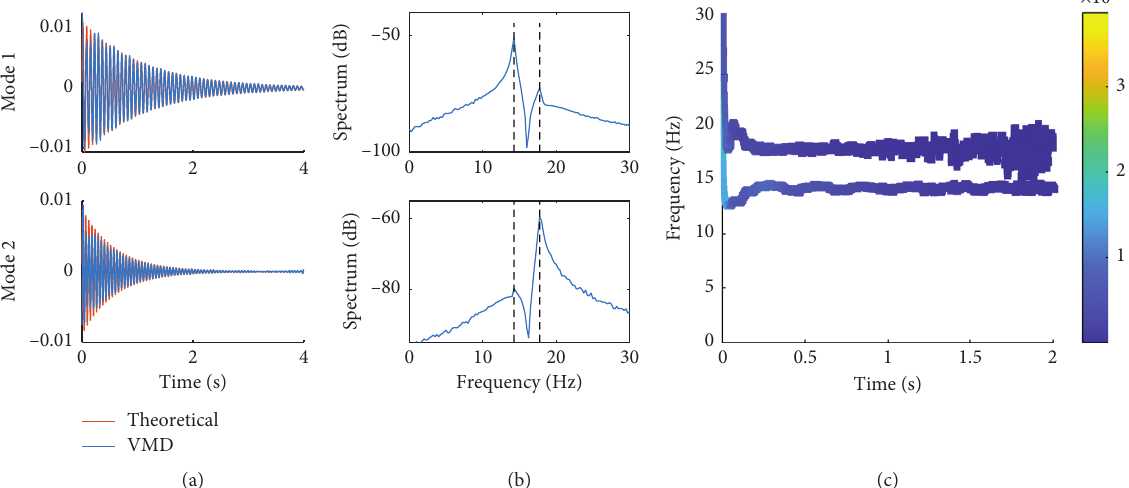
Figure 13: (a) The two separated modes by the proposed method with (b) the corresponding Fourier spectra and (c) the Hilbert spectrum. Stabilization diagram